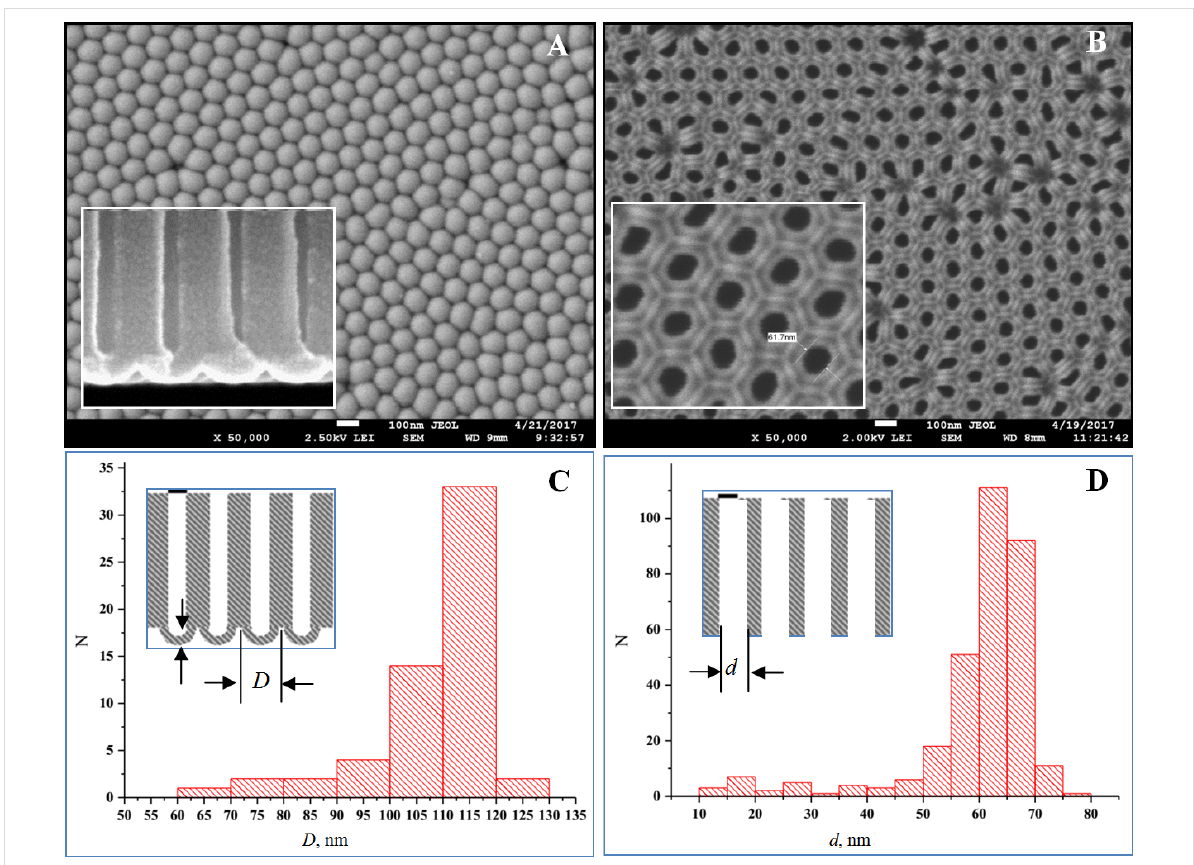
Figure 3: SEM images of the back surface of the sample before (A) and after (B) etching the barrier layer on the bottom of oxide pores. Histograms of distribution of the (C) oxide cell diameter ( D ) and (D) pore diameter ( d ), respectively.